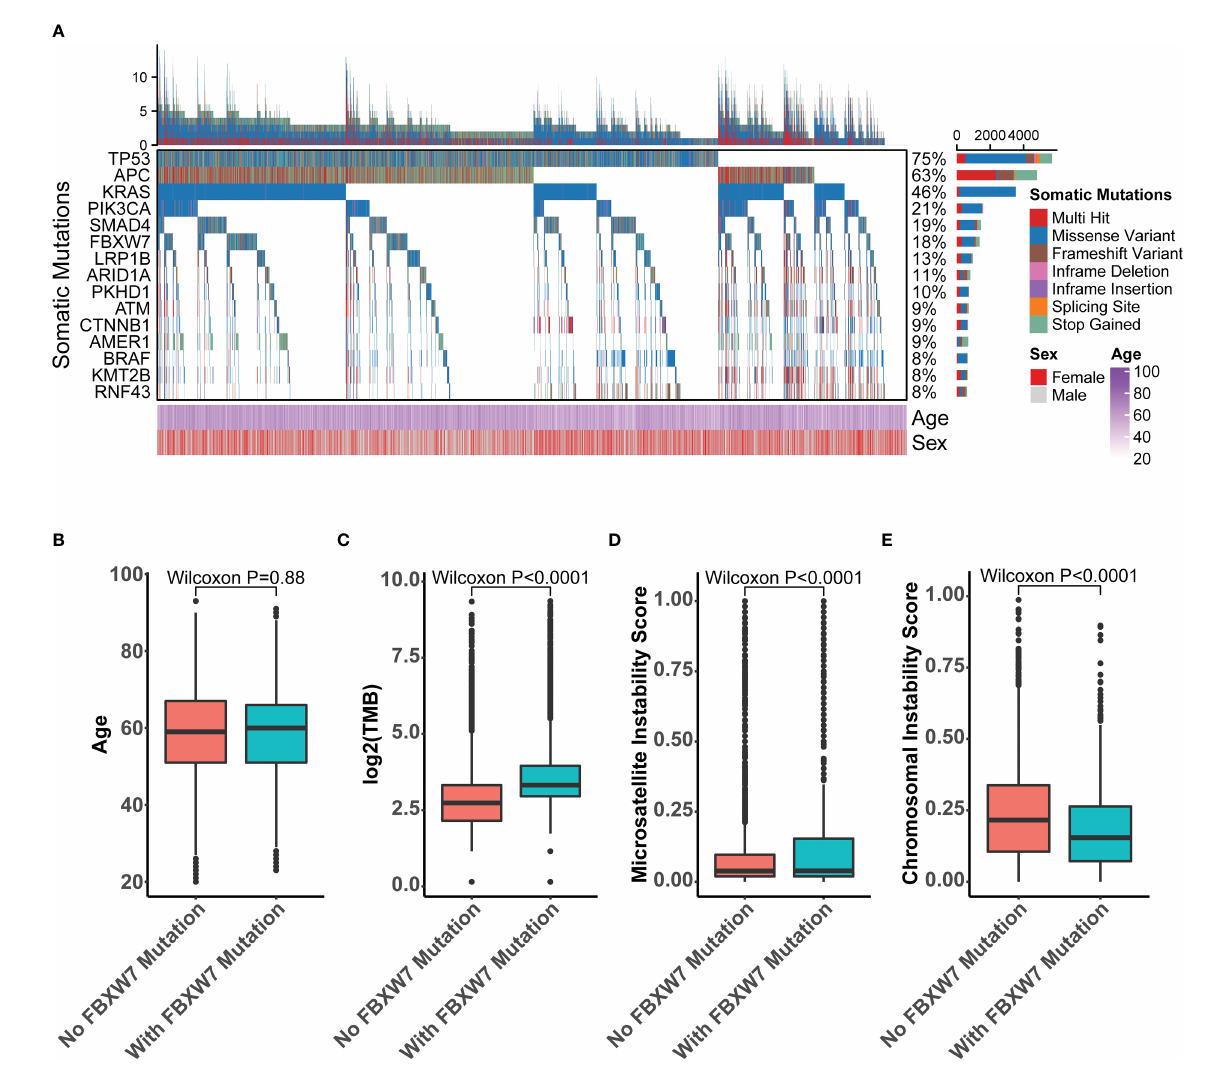
FIGURE 2 Molecular characteristics of FBXW7 somatic mutations in the recruitment cohort. (A) Oncoprint of top 15-mutated genes in the recruitment cohort; (B) Boxplot of the age of FBXW7-mutated and FBXW7-wild type patients; (C) Boxplot of the tumor mutation burden of FBXW7-mutated and FBXW7- wild type patients; (D) Boxplot of the microsatellite instability score of FBXW7-mutated and FBXW7-wild type patients; (E) Boxplot of the chromosomal instability scores of FBXW7-mutated and FBXW7-wild type